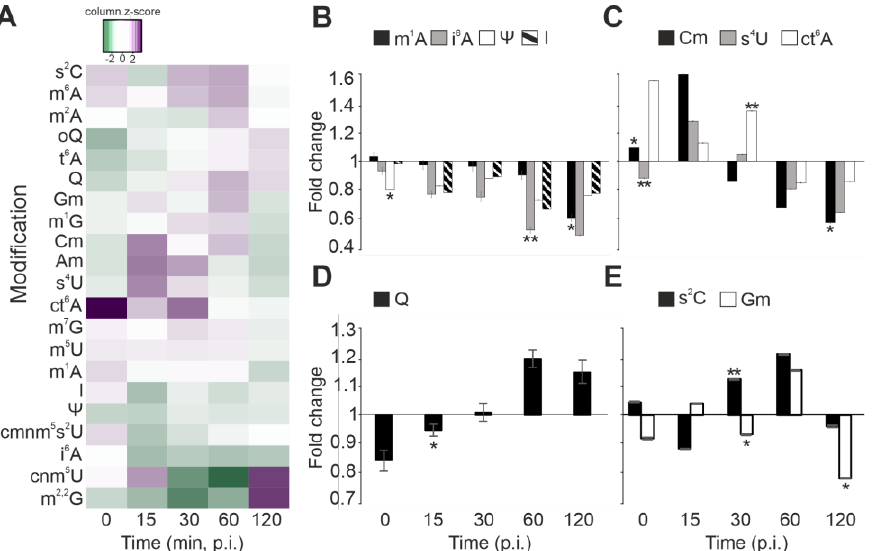
Figure 3. tRNA modification dynamics during infection in S. glacialimarina . ( A ) Heatmap presentation of the 18 modifications detected in S. glacialimarina throughout the infection cycle. The tRNA modification levels in infected cells are depicted as relative fold changes to the mock-infected controls. ( B – E ) Selected modifications grouped according to change in abundance relative to the infection stage; ( B ) decreasing trend, ( C ) initial upregulation followed by a decrease, ( D ) increasing trend, and ( E ) fluctuating modification levels. Error bars indicate standard deviation ( n = 3). * = p < 0.05, ** = p < 0.07.